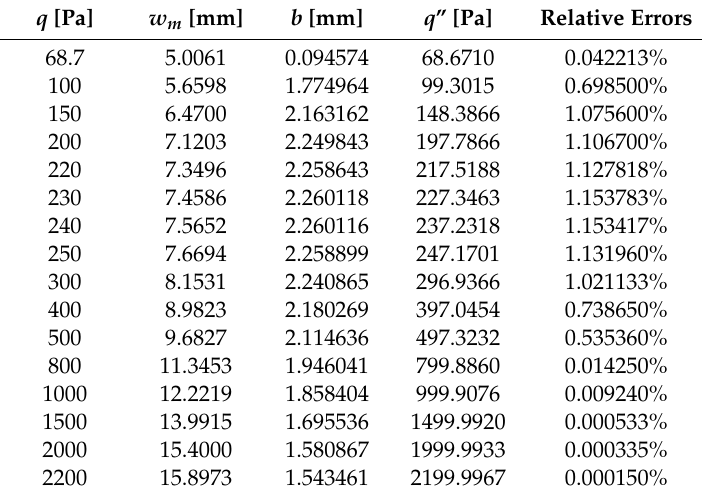
Table 1. The numerical results for k = 0.0015 N / mm and ∆ l = 0.05